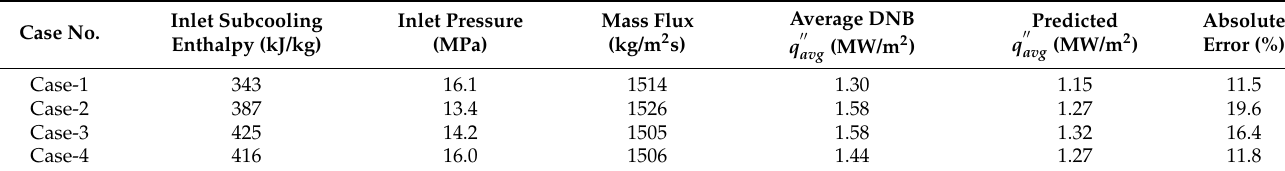
Table 6. Comparison of experimental data and predicted DNB data.